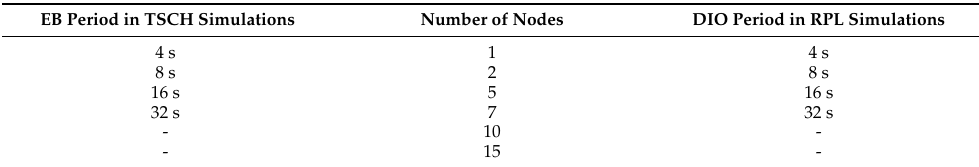
Figure 3. Network deployment in Cooja Simulator for N = 5. Table 5. Simulation parameters for TSCH and RPL